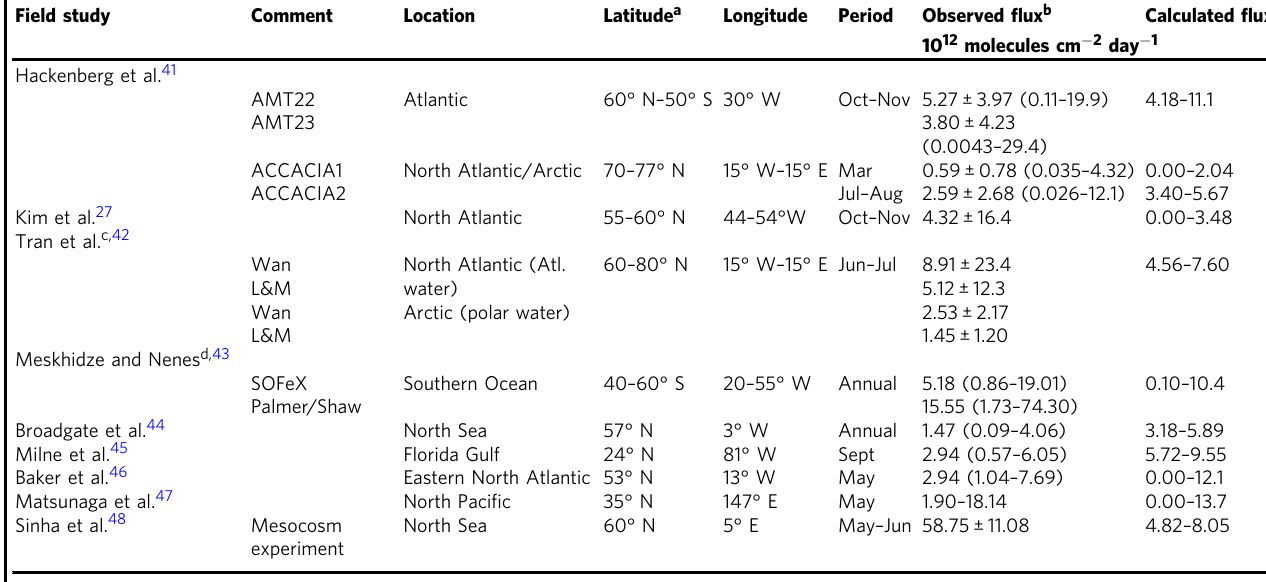
Table 1 Comparison of observed and calculated isoprene fl uxes for single fi eld studies Field